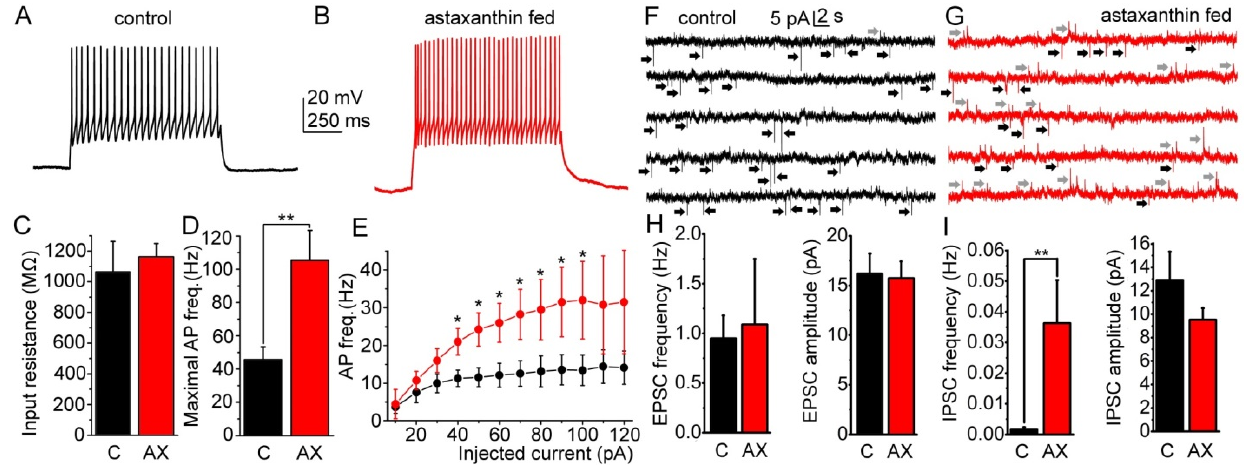
Figure 3. Effects of astaxanthin feeding on the excitability and synaptic currents of neurons in the hypothalamic arcuate nucleus. ( A , B ) Representative voltage traces of randomly chosen neurons of the arcuate nucleus in the control group ( A , black) and in the AX fed population ( B , red) elicited with 120 pA depolarizing current injection. ( C – E ) Statistical analysis of changes in input resistance ( C ), maximal action potential firing rate ( D ) and average action potential firing rate at different levels of depolarization ( E ). Black columns and graphs: control group (C), red columns, and graphs: astaxanthin fed population (AX). ( F , G ) Excitatory (black arrows) and inhibitory (gray arrows) postsynaptic currents (EPSCs and IPSCs, respectively) recorded from the control group ( F , black) and from the AX fed group ( G , red). ( H , I ) Statistical analysis of the EPSC frequency and amplitude ( H ) and the IPSC frequency and amplitude ( I ). Black columns: control group (C), red columns: astaxanthin fed population (AX). * p < 0.05, ** p < 0.01